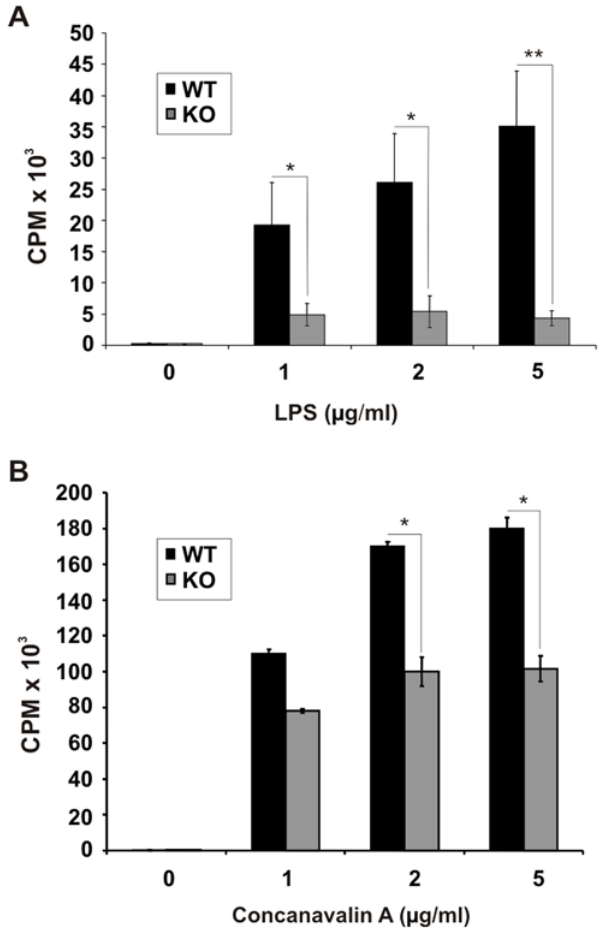
Figure 7. Impaired stimulatory potential in splenocytes from cIAP-1 KO mice. A and B. 1 6 10 6 PMC (A) and splenic T cells (B) from wildtype and cIAP-1 KO mice were stimulated with different doses of LPS and Con A, respectively, and the stimulatory potential was measured by 3 H-thymidine incorporation. Data represent the mean of counts per minutes CPM 6 SEM from three independent experiments. * p # 0.05; ** p # 0.01.